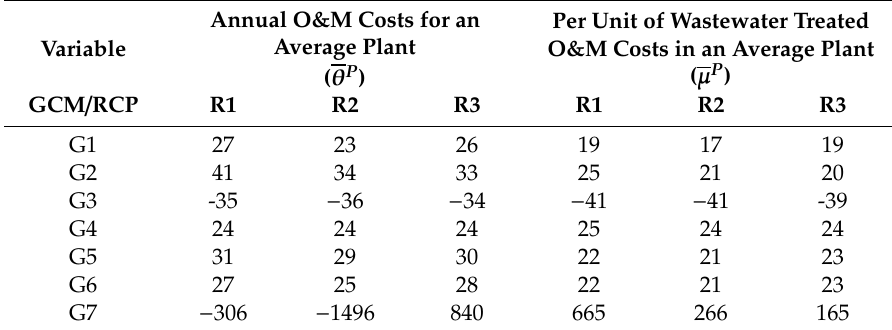
Table 8. Ratio of di ff erences in calculated annual O&M costs between simulations by climate models and emission